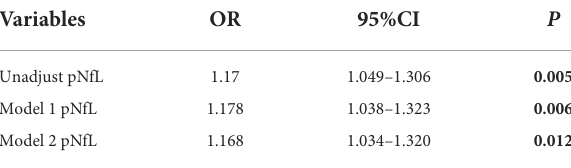
TABLE 2 Odds ratios for pNfL by END compared to Non-END.